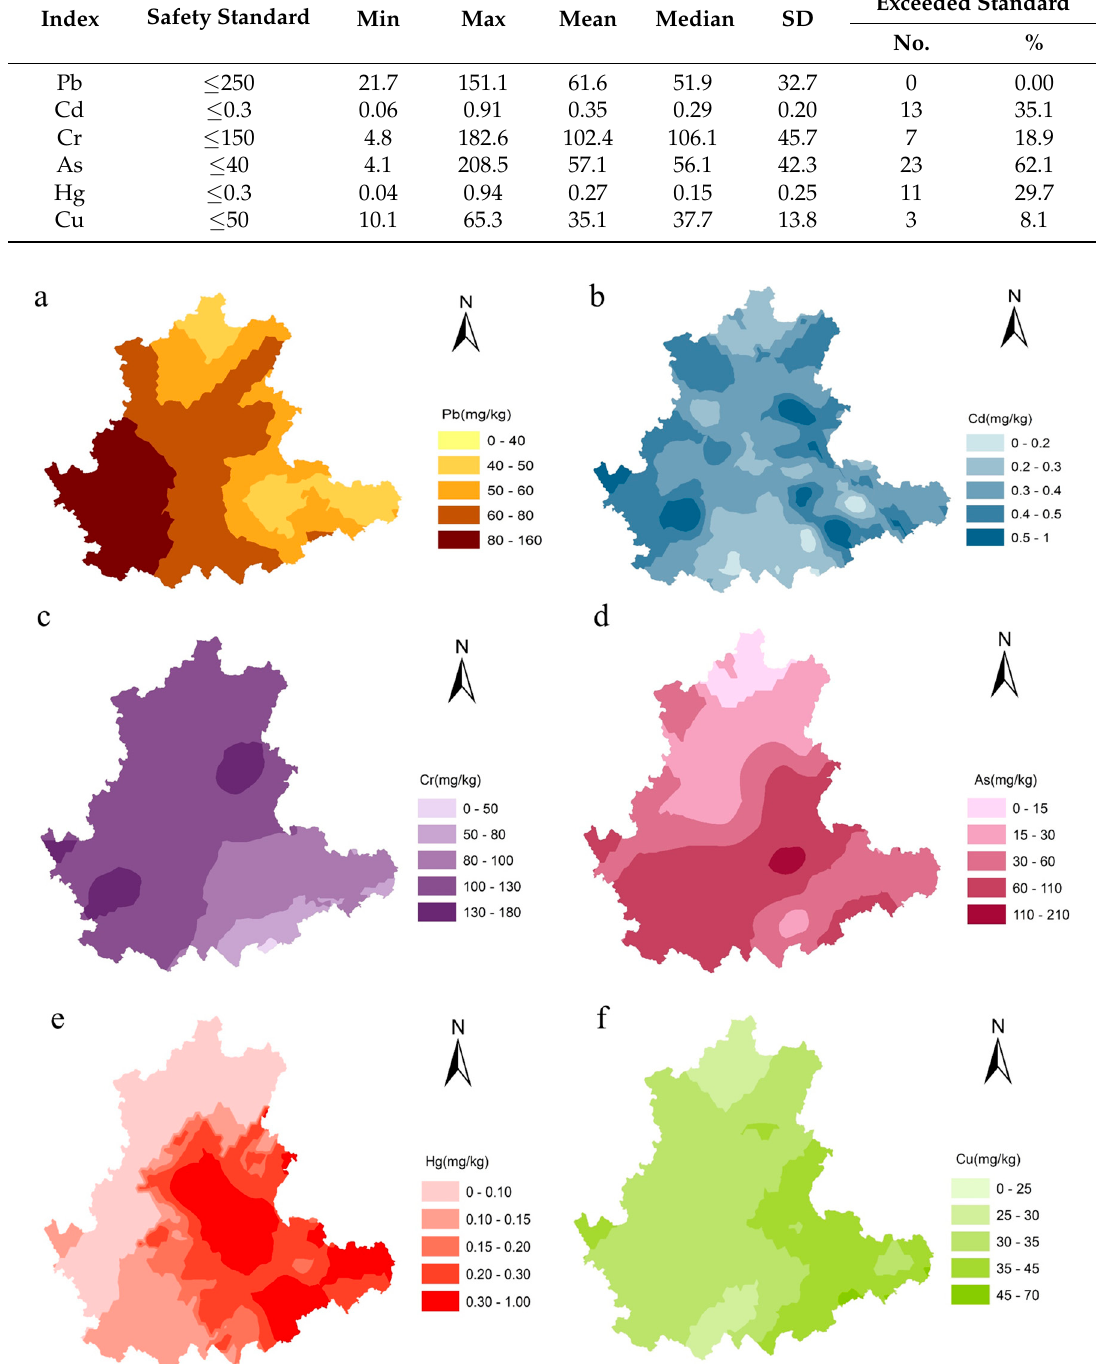
Table 5. Analysis of heavy metal contents in P. notoginseng cultivation soil ( n = 37, mg·kg − 1 ).